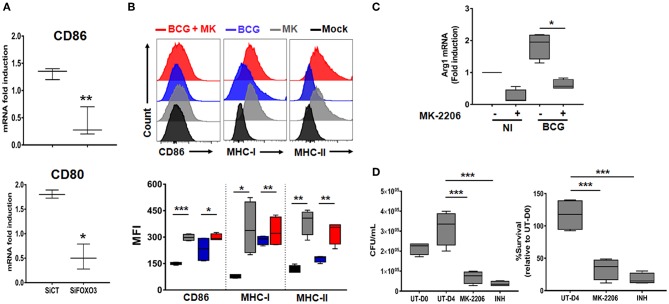
FOXO3 tunes phenotypic maturation of mycobacteria-infected macrophages. (A) Human monocytes were transfected either with SiCT or SiFOXO3 for 48 h followed by PPD stimulation and incubation with the autologous lymphocytes for 4 days. Whole cells were then collected and tested for the expression levels of CD80 and CD86 by qRT-PCR. Data are presented as box and whiskers graphs (min to max) from three independent experiments (i.e., MDMs from 3 different donors), each one carried out in triplicate (n = 3, **p < 0.001, ***p < 0.0001). (B) Non-infected or BCG-infected BMDMs were treated or not with MK-2206 (5 μM) for 24 h. The expression levels of the M1 phenotype surface markers CD86, MHC-MHC-II, and MHC-I, in CD11b+ cells, were determined by FACS analysis using specific antibodies. FACS analysis was performed on two independent experiments and each sample was run in triplicates (n = 2, *p < 0.05, **p < 0.001, ***p < 0.0001). (C) J774A.1 were mock or infected with BCG at an MOI = 10 for 3 h, washed then treated or not with the Akt inhibitor MK (5 μM) for 24 h. The transcript levels of M2 marker, Arg1, was assessed by RT-PCR. Data are presented as box and whiskers (min to max) and are from two separate experiments, each one carried out in triplicate (n = 2, *p < 0.05). (D) TDMs were infected with BCG at an MOI = 10 for 3 h. Following incubation, cells were treated with Amikacin (200 μg/ml) for 1 h to remove extracellular bacteria. The infected cells were then washed and treated with MK (5 μM) for 4 days. The antibiotic Isonicotinylhydrazide (INH) was used as positive control. Cells were lysed with sterile PBS containing 0.1% triton X100 and 10-fold serial dilutions of lysates were plated on MB7H11 for CFU Enumeration. The Intracellular colony forming units were determined at the indicated time points. UT-D0, untreated at Day 0; UT-D4, untreated at Day 4. Data are shown as box and whiskers (min to max values) and representative of two separate experiments, each one carried out in quadruplets. Asterisks indicate statistical significance (n = 2, ***p < 0.0001).